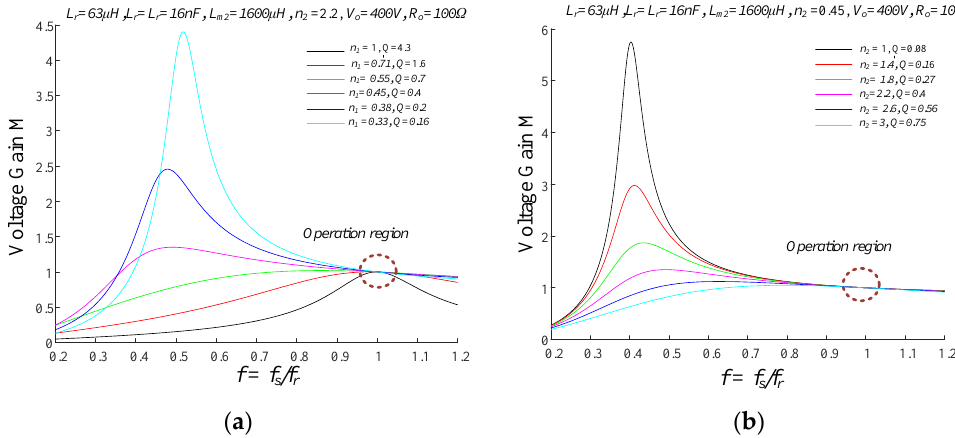
Figure 8. Output voltage gain according to the transformer turn ratios. ( a ) Output voltage gain according to a turn ratio of transformer T 1 . ( b ) Output voltage gain according to a turn ratio of transformer T 2 .